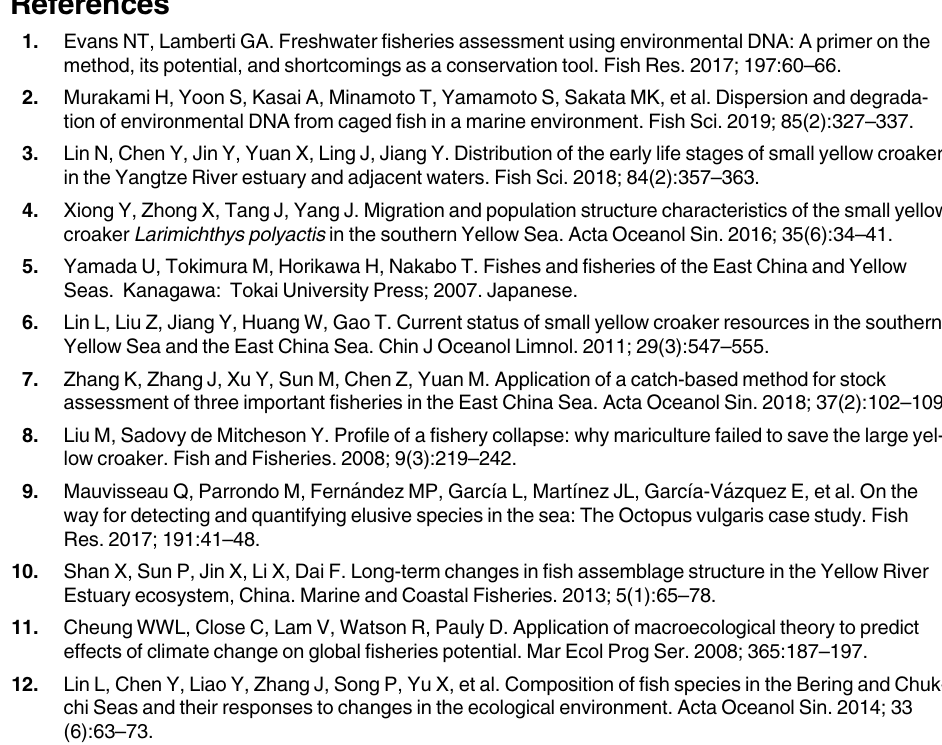
S1 Table. Sampling locations and eDNA concentrations of small yellow